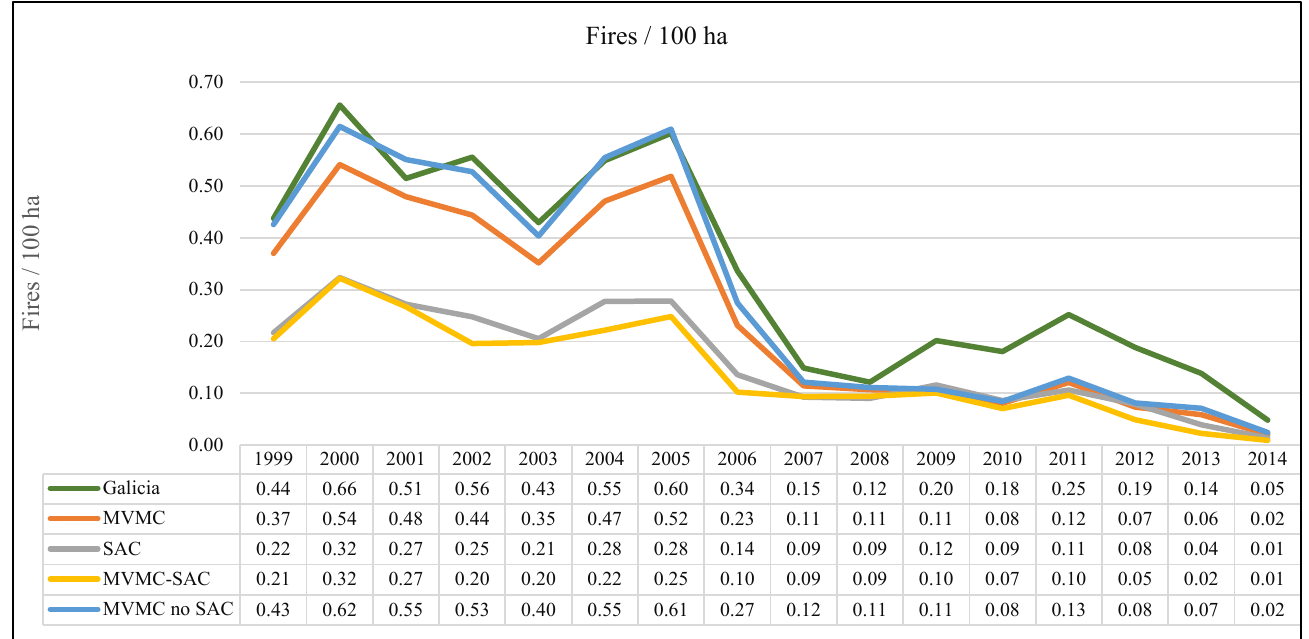
After 2004, the rate of forest fires for the different territorial groups analysed tended to converge, with very close values between all of them, such that the SACs did not seem to benefit from the same decrease as the other study groups (Figure 11).